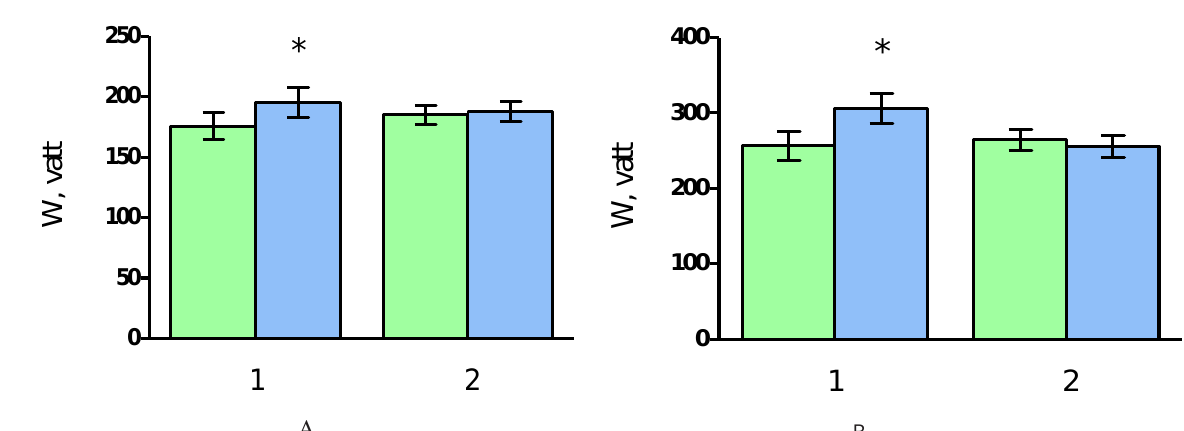
Fig. 2. Mean power of test loads at AnMT level (A) and MOC (B) in experimental and control groups (n = 14): 1 – experimental group, 2 – control group. * − p ≤ 0.05; W – power; t – time, minutes. − beginning of the research, − end of the research.